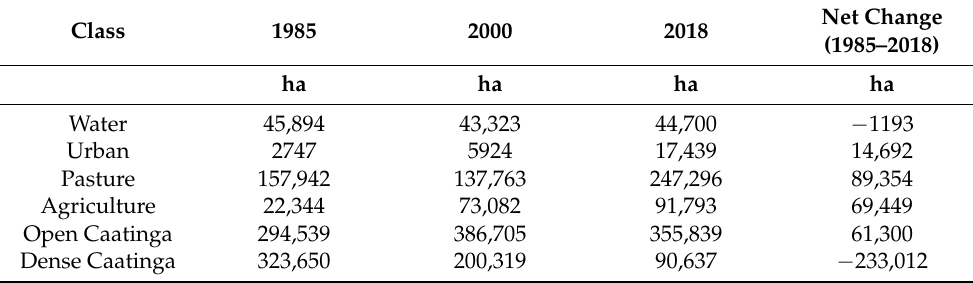
Table A4. Land use/land cover type estimated (ha) for 1985, 2000 and 2018 in the study area.